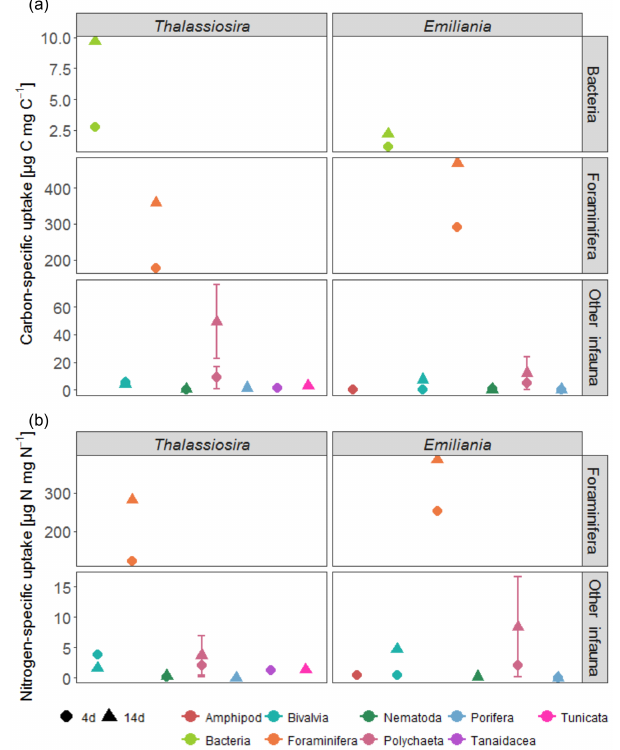
Figure 5. Specific uptake of carbon (a) and nitrogen (b) for infauna >250µm and bacteria. No nitrogen-specific uptake was quantified for bacteria. Error bars indicate SD of specific uptake of replicate